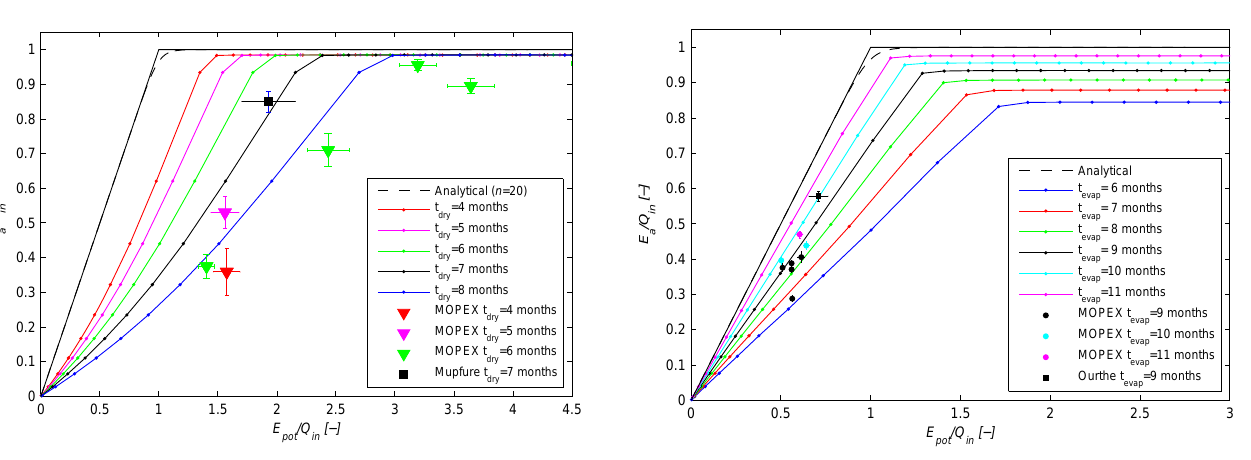
Figure 3. Sensitivity to periodic dry spells in the forward model. MOPEX catchments are filtered to have only those catchments hav- ing at least 1 month with a median rainfall < 2 . 5mmmonth − 1 and a coefficient of variance < 0 . 5 for all months with a median rainfall > 25mmmonth − 1 . The final number of dry months was determined maximizing the difference between the mean monthly precipitation of the X driest months minus the mean monthly precipitation of the 1 − X wettest months, where X = 1 , 2 ... 12. Error bars indicate 1 standard deviation and are determined with bootstrap sampling.